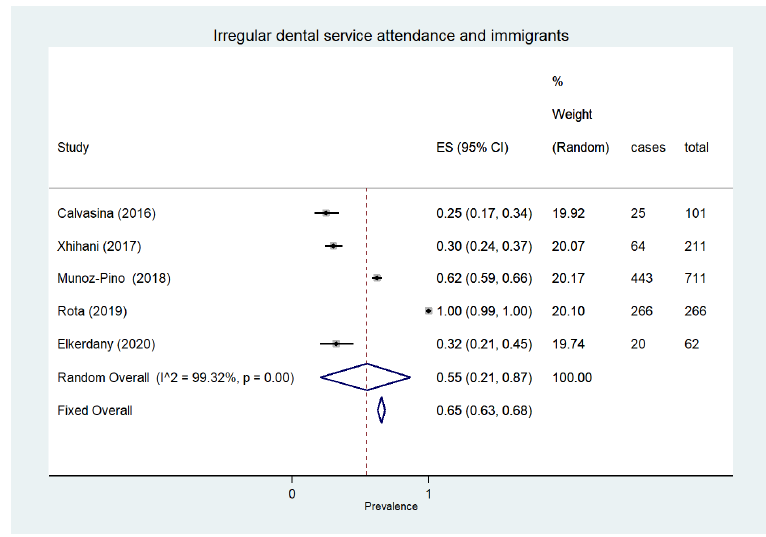
Figure 5. Irregular dental service attendance and immigrants.